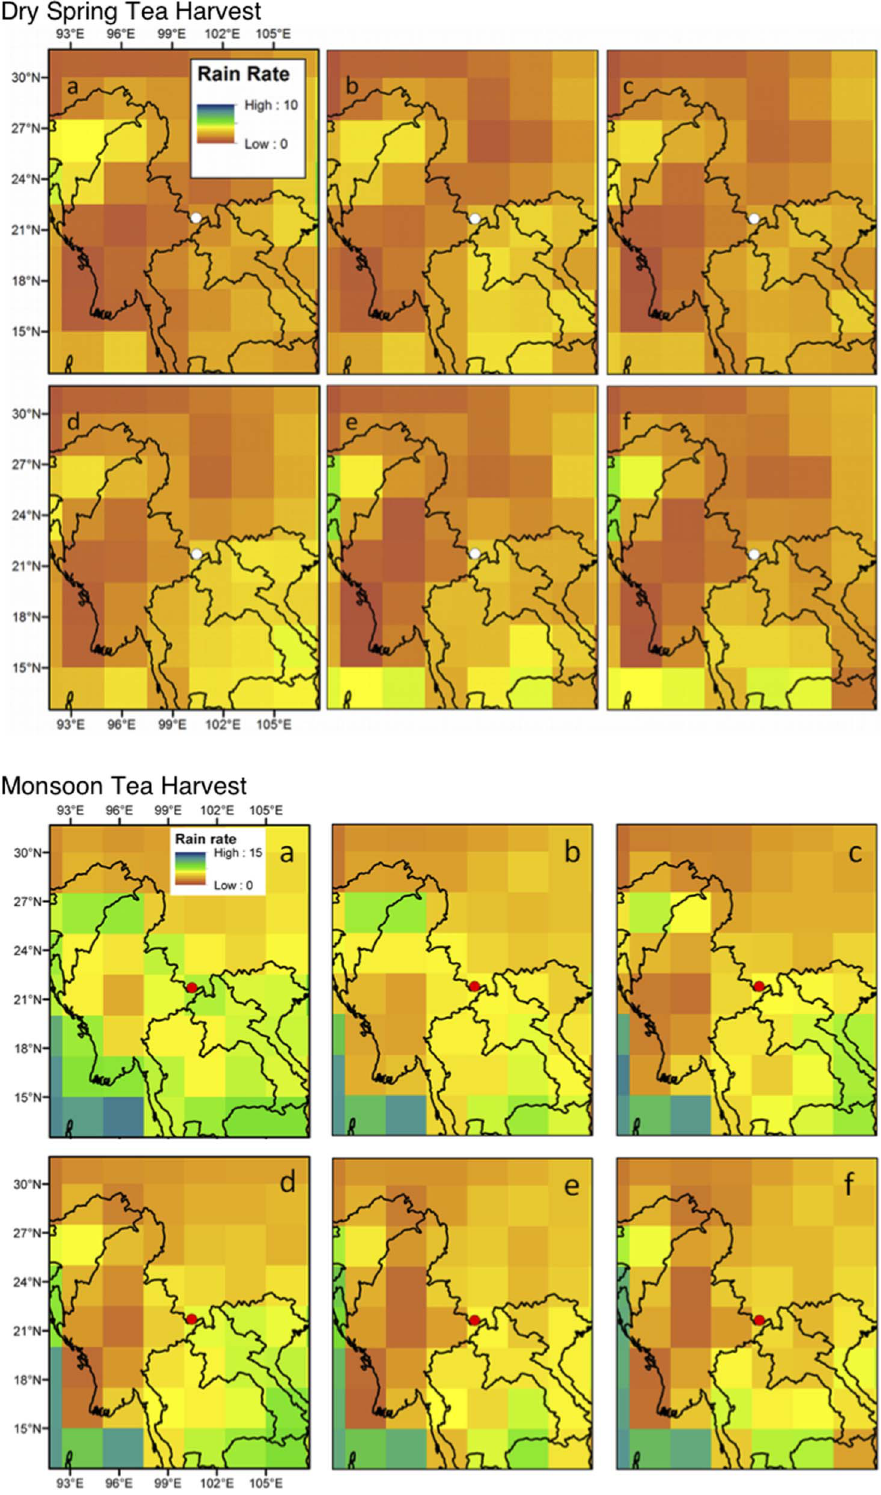
Figure 8. Historical Precipitation Trends During the Dry Spring and Monsoon Tea Harvests. Comparison of average rain rate for dry spring (top) and monsoon (bottom) tea harvests during the following periods: a) 1979–1984, b) 1985–1989, c) 1990–1994, d) 1995–1999, e) 2000– 2004, f) 2005–2010. The study site is located at the dot in the middle of each map.